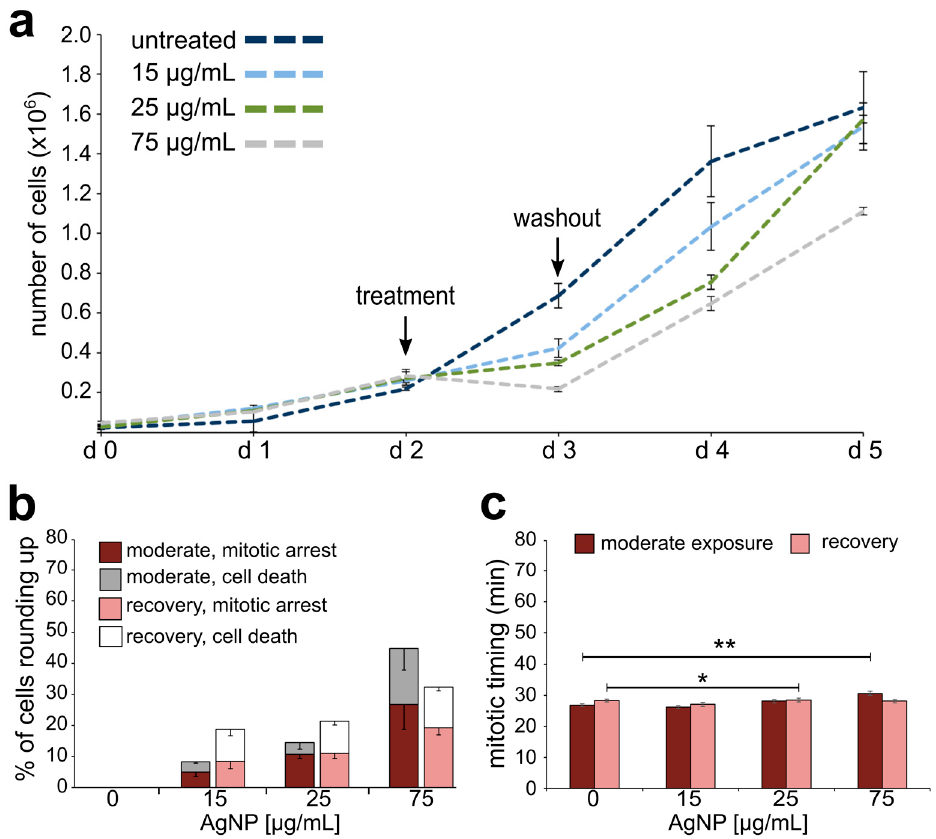
Figure 5. Effects on cell division and cell proliferation from moderate AgNP exposure and recovery. (a) Growth curves for cells exposed to a moderate treatment regime with increasing concentrations of AgNPs. (b) Percentage of cells observed to either arrest or die after rounding up. The data corresponding to events observed during the last of six treatments are shown in darker colors ( maroon and grey ), whereas the data corresponding to events observed during recovery from the last treatment are shown in lighter colors ( pink and white ). (c) Mitotic timing in cells completing mitosis during the last treatment of a moderate AgNP exposure ( maroon bars ) or recovering from the last treatment of a moderate AgNP exposure ( pink bars ). * t-test, p < 0.05; ** t-test, p < 0.005.